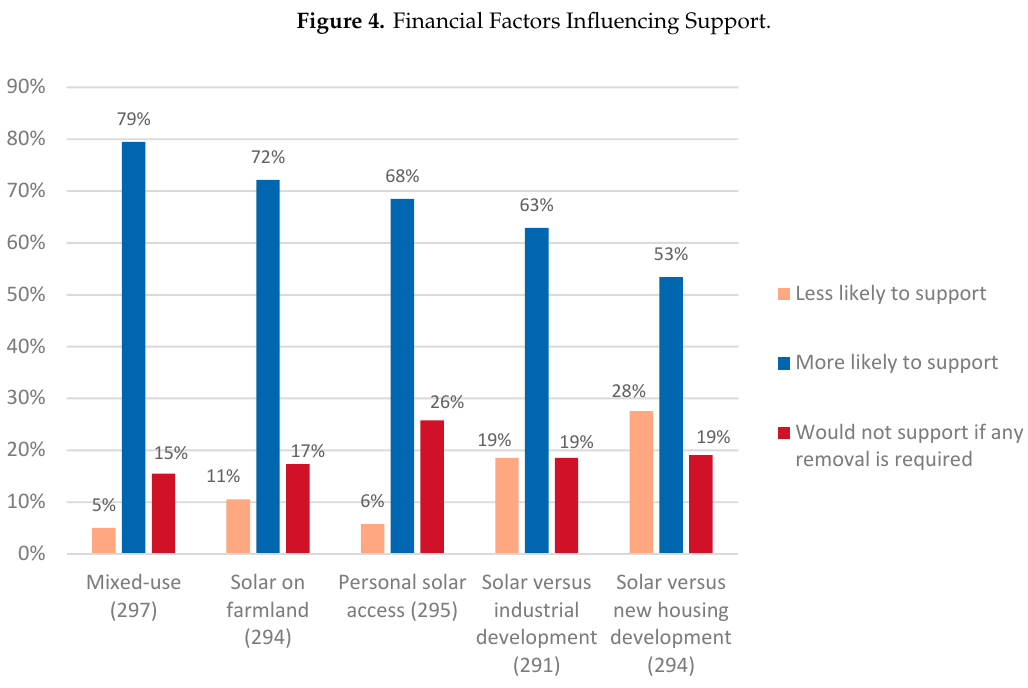
Figure 5. Siting Factors Influencing Support.